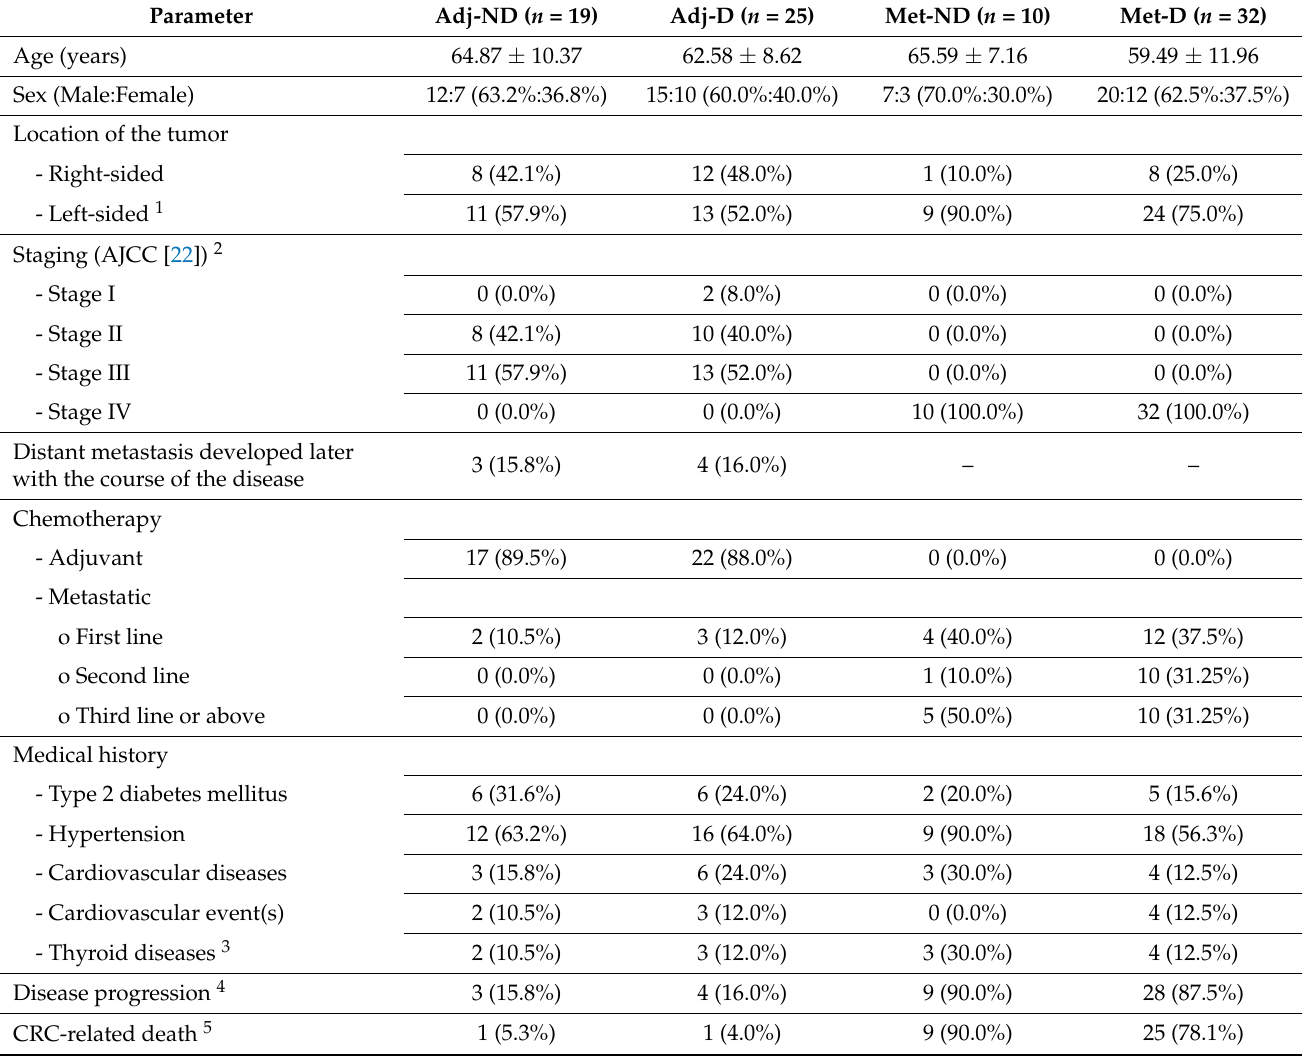
Table 1. Demographic and clinical characteristics of study participants. The significant differ- ences found in staging ( p < 0.0001), lineage of chemotherapy ( p < 0.0001), and the occurrence of death/progression ( p < 0.0001) was related only to the presence of metastases. Unit of frequency data is the number of observations